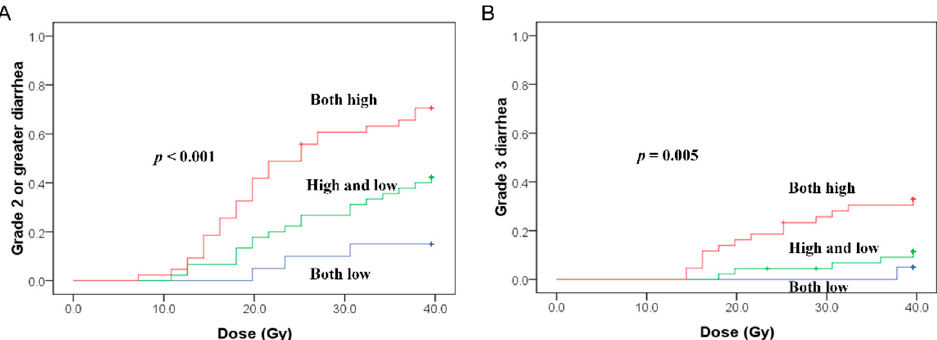
Figure 3. The combination of the small bowel volume effect and rectal dose effect on Grade 2 or greater ( A ) and Grade 3 ( B ) diarrhea. Both high indicates the patient group with V100% ≥ 60 mL and MRD ≥ 32.75 Gy. Either high indicates the patient group with V100% ≥ 60 mL and MRD < 32.75 Gy or V100% < 60 mL and MRD ≥ 32.75 Gy. Both low indicates the patient group with V100% < 60 mL and MRD < 32.75 Gy.